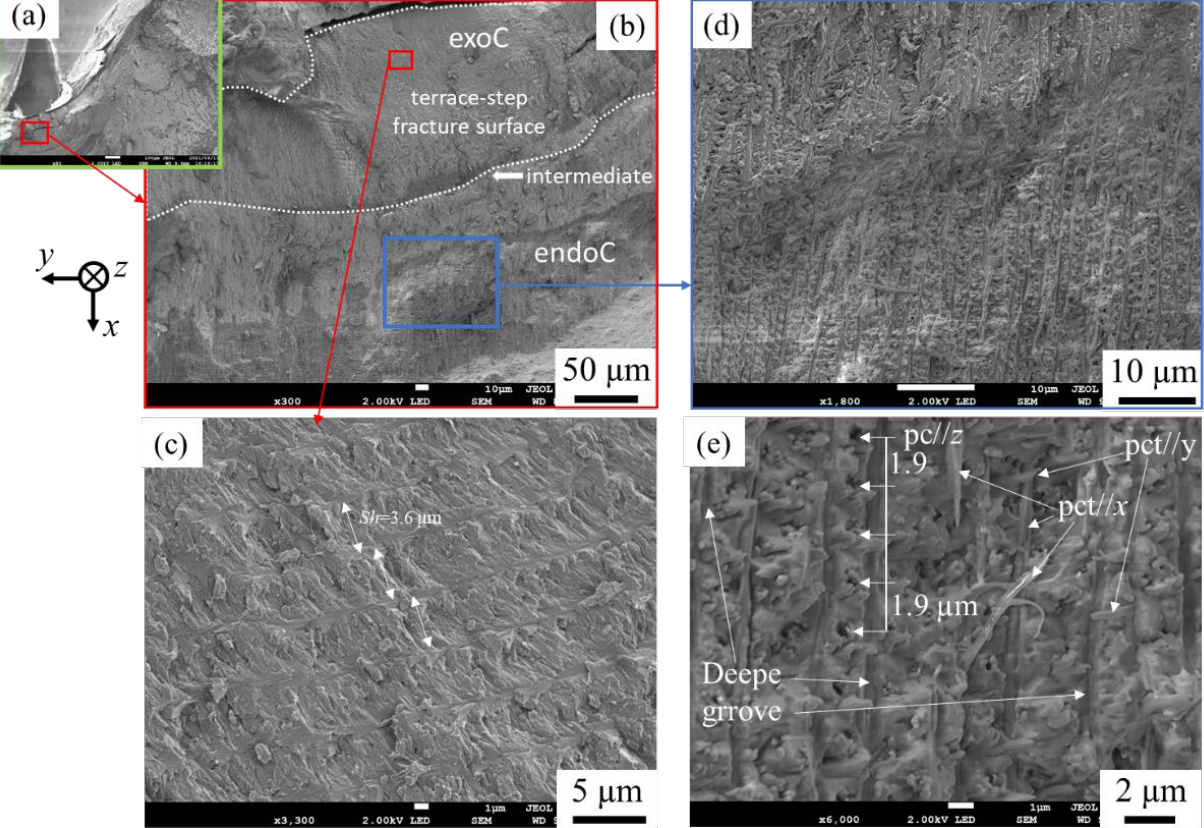
Figure 4. SEM micrograph near the valley of the ( a ) fracture surface of the denticle; ( b ) enlarged SEM micrographs of the area enclosed by rectangles in ( a ); SEM micrographs of ( c , d ) the endocuticle layer; and ( e ) the exocuticle layer. Here, pc denotes pore canal, and pct denotes pore canal tubules.